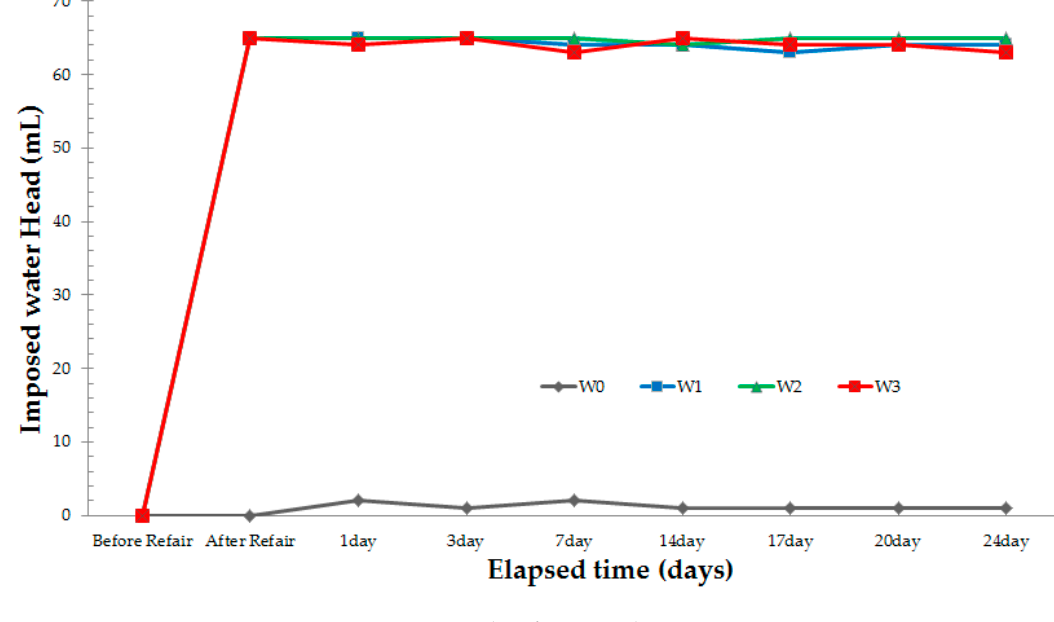
Figure 10. Results of water tightness test.